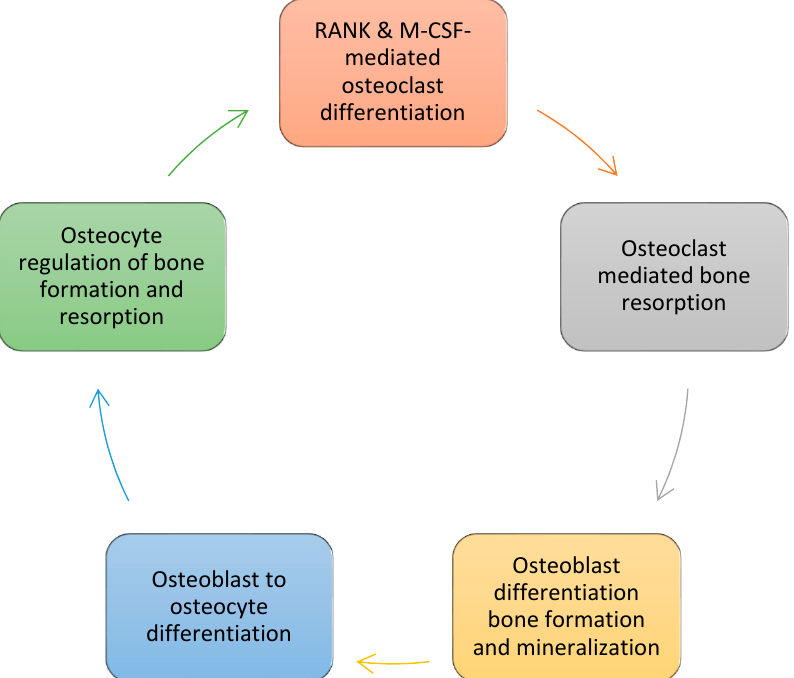
Figure 1. The cycle of bone formation. RANK and macrophage colony stimulating factor (M-CSF) signaling initiates osteoclast di ff erentiation from hematopoietic stem cell precursors. Mature multilobed osteocytes resorb bone, releasing growth factors (IGF-1, TGF- β , and BMPs) that initiate osteoblast di ff erentiation from mesenchymal stem cell precursors. Osteoblasts form and mineralize bone matrix, and eventually evolve into osteocytes—the master regulators of bone homeostasis.